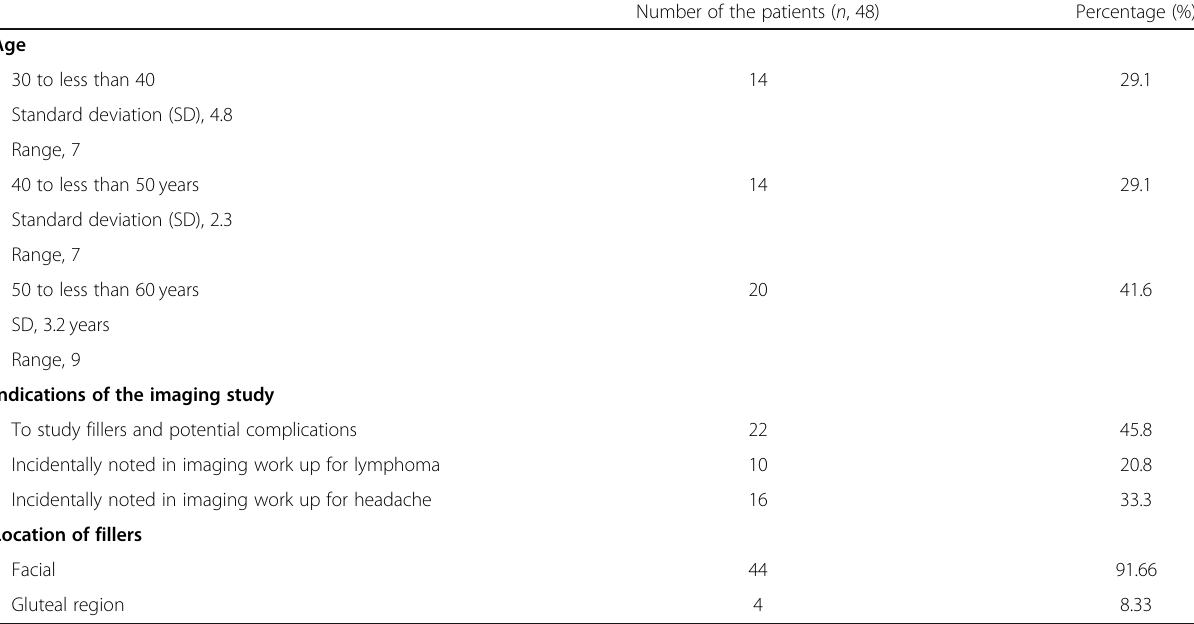
Table 1 Distribution of the studied patients according to different parameters